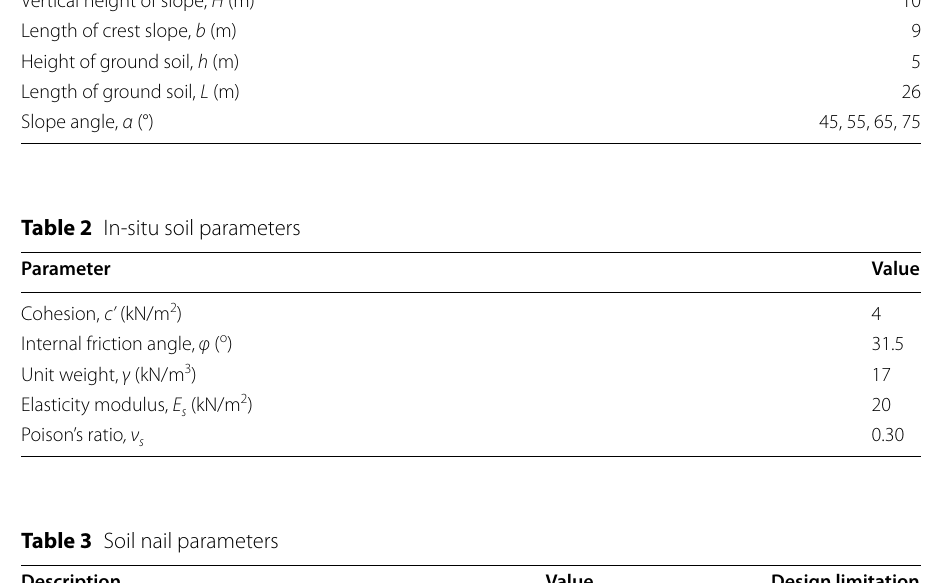
Table 1 Slope geometry Description Value Vertical height of slope, H (m) 10 Length of crest slope, b (m) 9